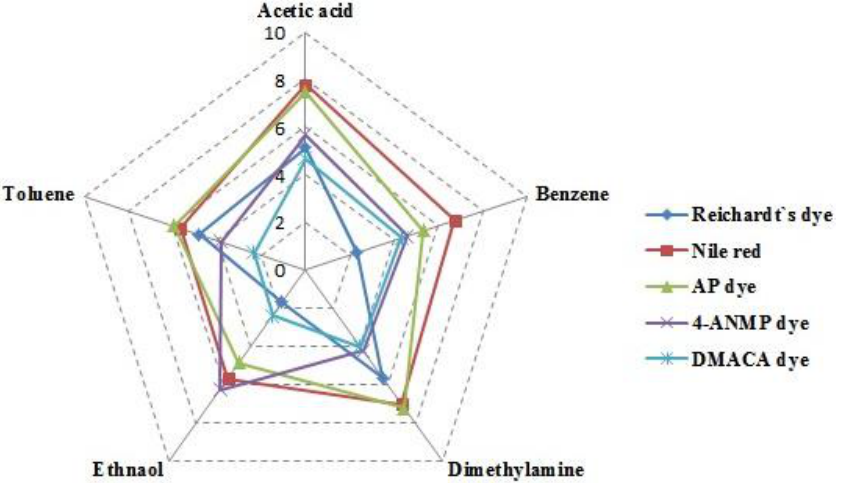
Figure 8. Average response polar plot of various VOC